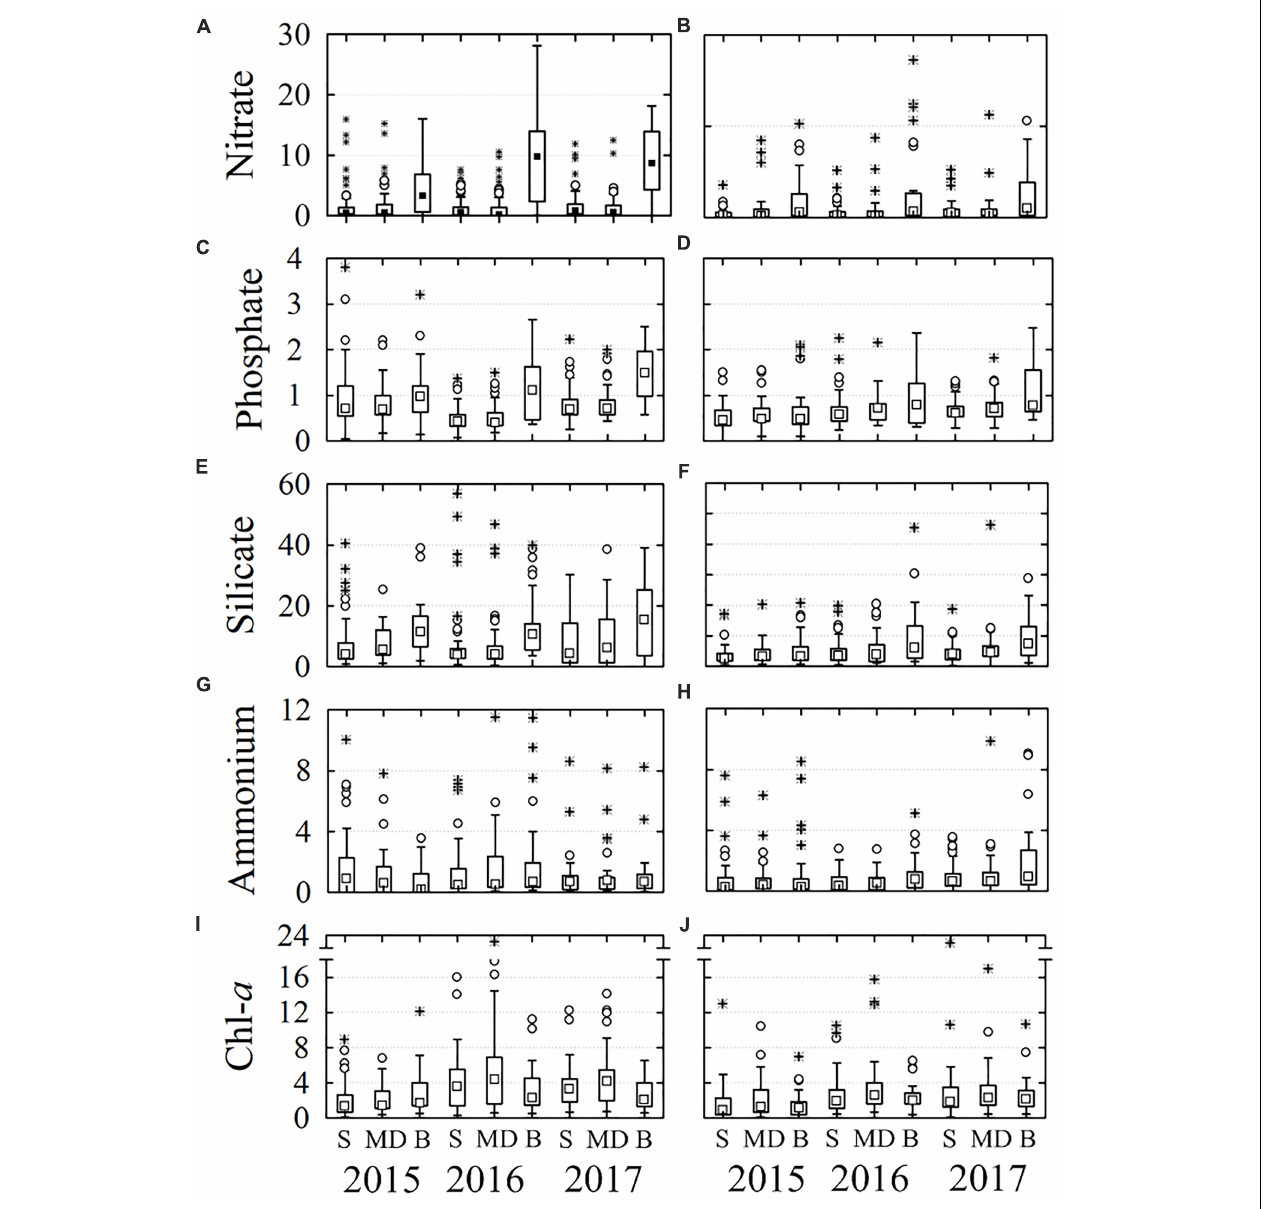
FIGURE 4 | Box and whiskers graphs of nutrients and chlorophyll- a , recorded from 2015 to 2017. Boxes include percentiles 25th, 50th, and 75th; extreme values. The panels (A,C,E,G,I) correspond to the first semester and (B,D,F,H,J) to the second one of each year. S, surface; MD, mid depth; B, bottom.